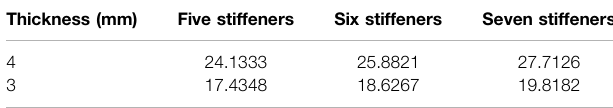
TABLE 7 | Mass of the cascade assembly (Kg).